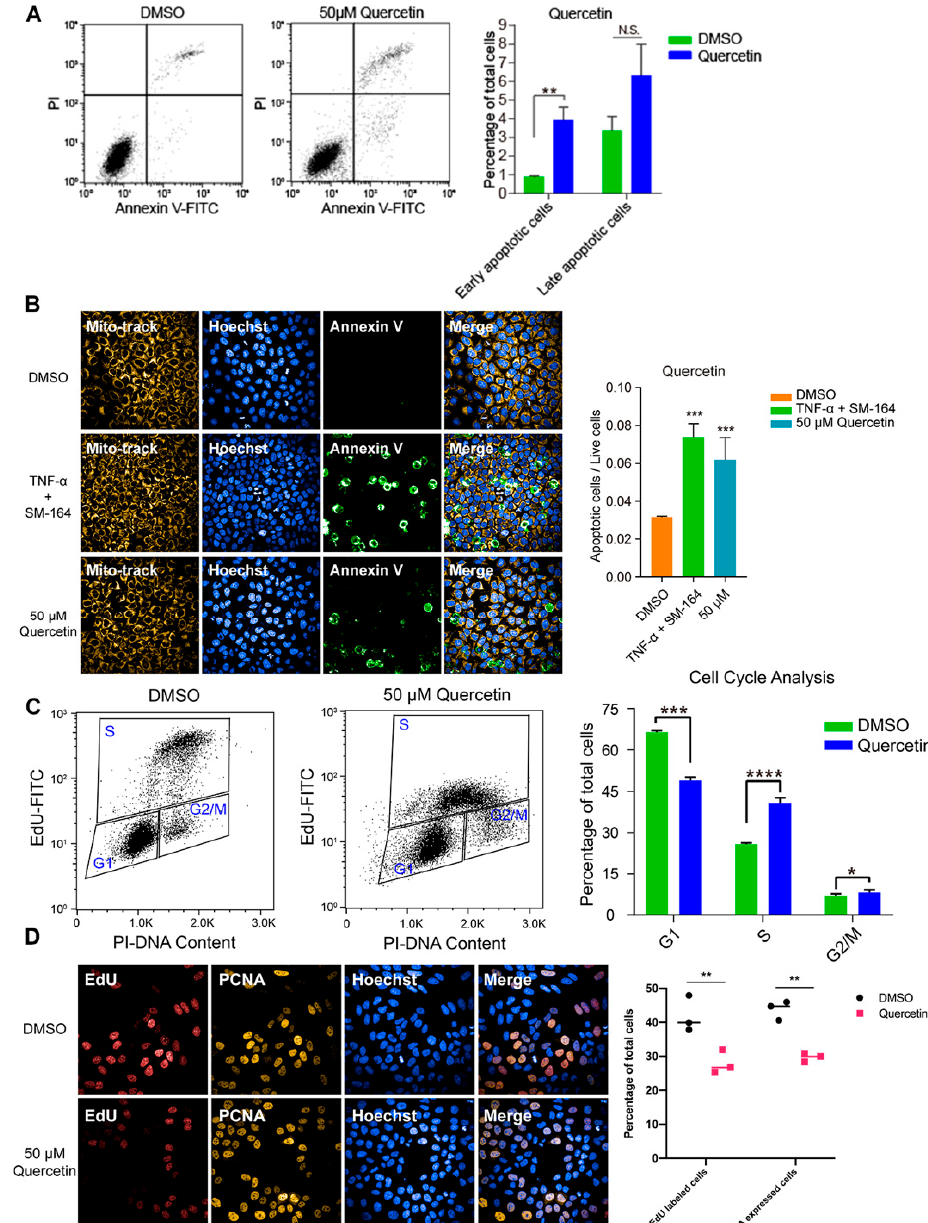
Figure 5. High dose of quercetin induced apoptosis and cell cycle arrest in MCF-7 cells. ( A ) Flow cytometry and statistical results of apoptosis in MCF-7 cells treated with DMSO or 50 µM quercetin for 48 h. TNF- α +SM-164 was positive control. ( B ) Immunofluorescence staining and statistical results of apoptosis in MCF-7 cells treated with DMSO or 50 µM quercetin for 48 h. ( C ) Flow cytometry and statistical results of cell cycle arrest in MCF-7 cells treated with DMSO or 50 µM quercetin for 48 h. ( D ) Immunofluorescence results of indicators EdU and PCNA in MCF-7 cells treated with DMSO or 50 µM quercetin for 48 h. Cells were observed under 40× oil laser confocal microscope. Data was shown as the mean ± SD. * p < 0.05, ** p < 0.01, *** p < 0.001, **** p < 0.0001. ns indicates no significant difference.